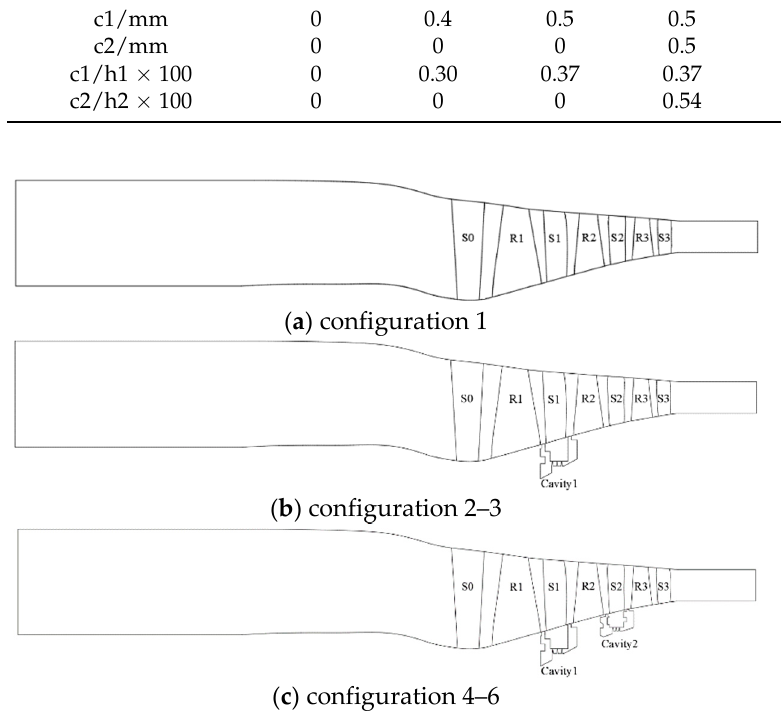
Figure 7. Silhouettes for different configurations.